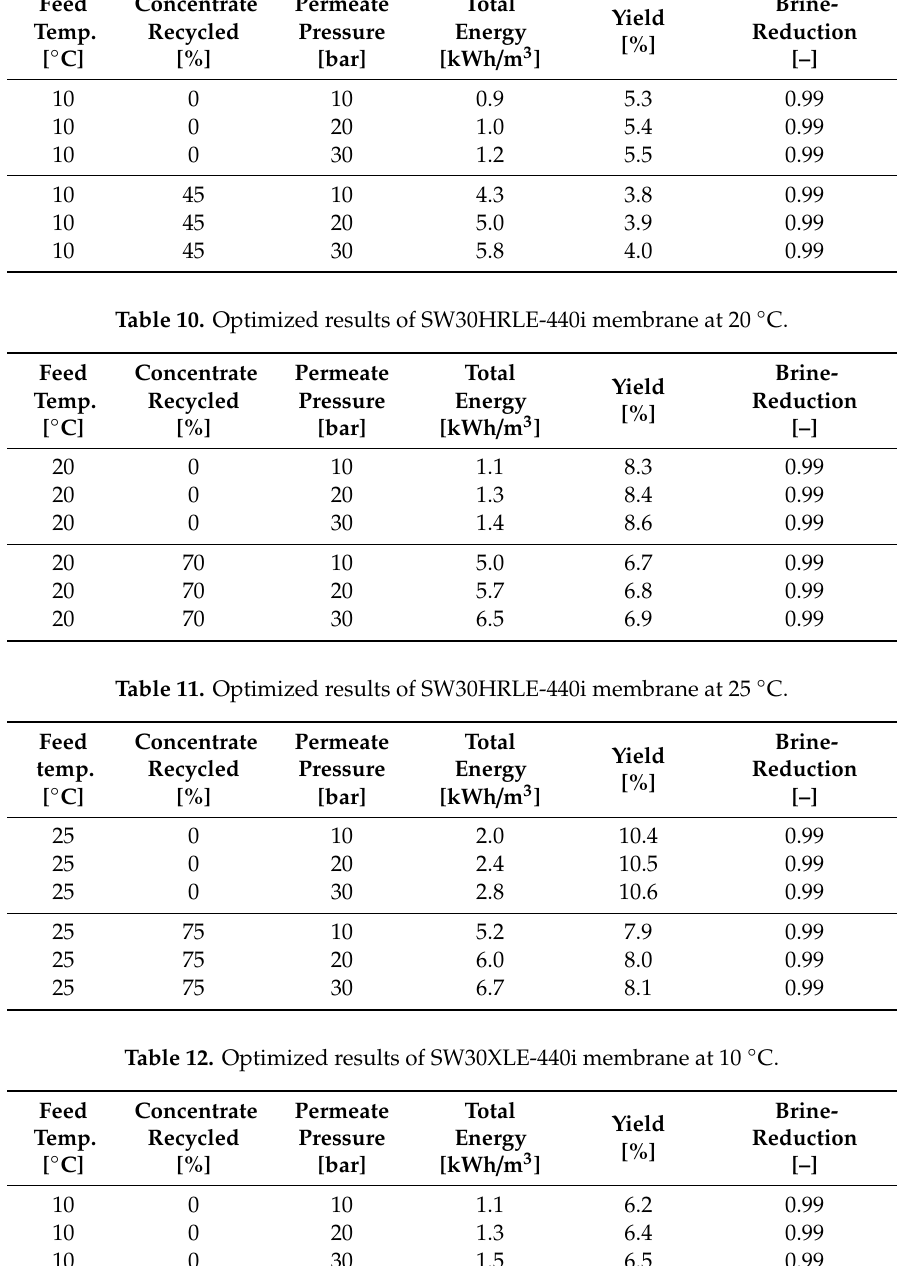
Table 9. Optimized results of SW30HRLE-440i membrane at 10 ◦ C. Feed Temp.